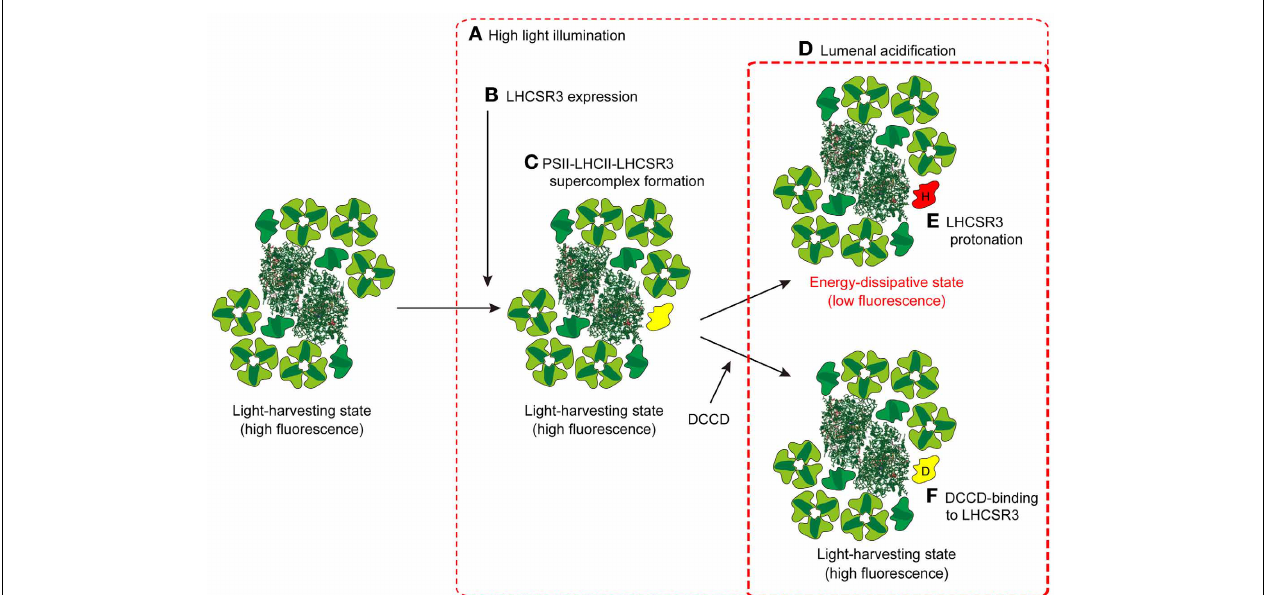
FIGURE 3 | A model for the induction of qE in C. reinhardtii . When C. reinhardtii cells are exposed to HL for several hours (A) , the expression of LHCSR3 is induced (B) . LHCSR3 ( yellow ) is then associated with the PSII-LHCII supercomplex to form the PSII-LHCII-LHCSR3 supercomplex (C) . Though the PSII-LHCII-LHCSR3 supercomplex is still in a light-harvesting state under dark or LL conditions, it becomes energy-dissipative upon